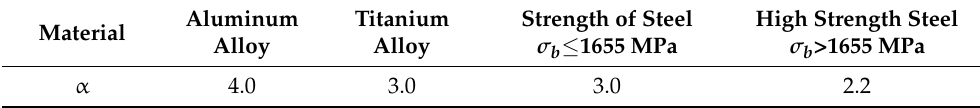
Table 4. The shape parameter of the welding seam.